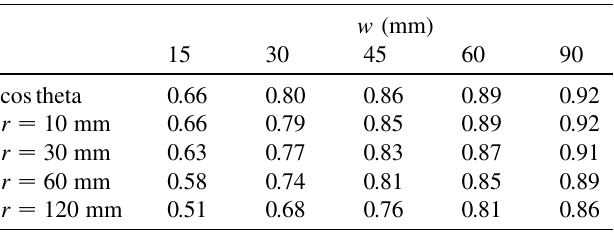
TABLE IV. Ratio between the short sample field evaluated for Nb-Ti, different sector widths through Eq. (22) and B (cid:5) c 2 and aperture radii, for filling factor (cid:5) (cid:1) 0 : 35 .